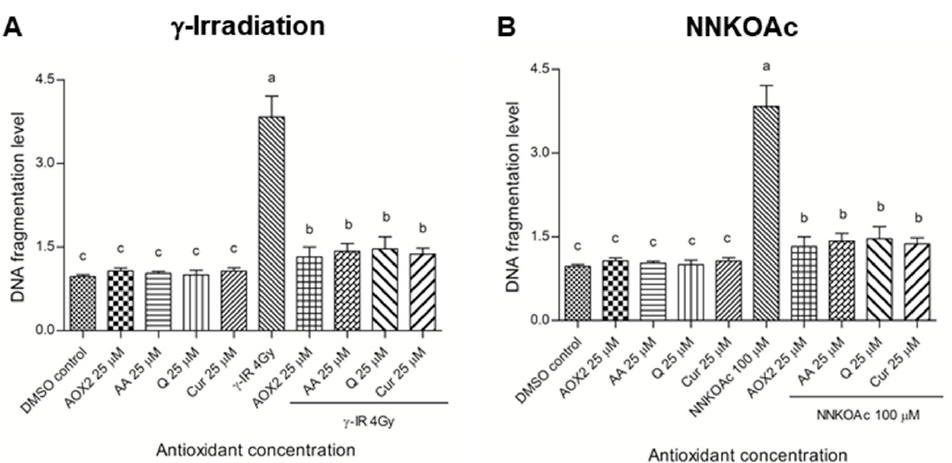
Figure 4. DNA fragmentation was reduced by the tested antioxidants in γ -irradiation ( A ) or carcino- gen ( B ) induced BEAS-2B cells. DNA fragmentation was determined by ELISA. Experimental values are mean ± SD of three independent experiments in triplicate. One-way analysis of variance was performed with Tukey’s pairwise comparison. Means that share the same letter are not significantly different at p ≤ 0.05. Abbreviations: AOX2, dietary antioxidant formulation-2; AA, ascorbic acid; Q, quercetin; Cur, curcumin; DMSO, dimethyl sulfoxide; γ -IR, γ -irradiation. Since histone protein serine 139 phosphorylation is a recognized cytological marker of DNA DSBs, the γ -H2AX immunofluorescence assay was used to evaluate DNA damage and the DDR [31]. The nucleus was stained with DAPI and observed under a